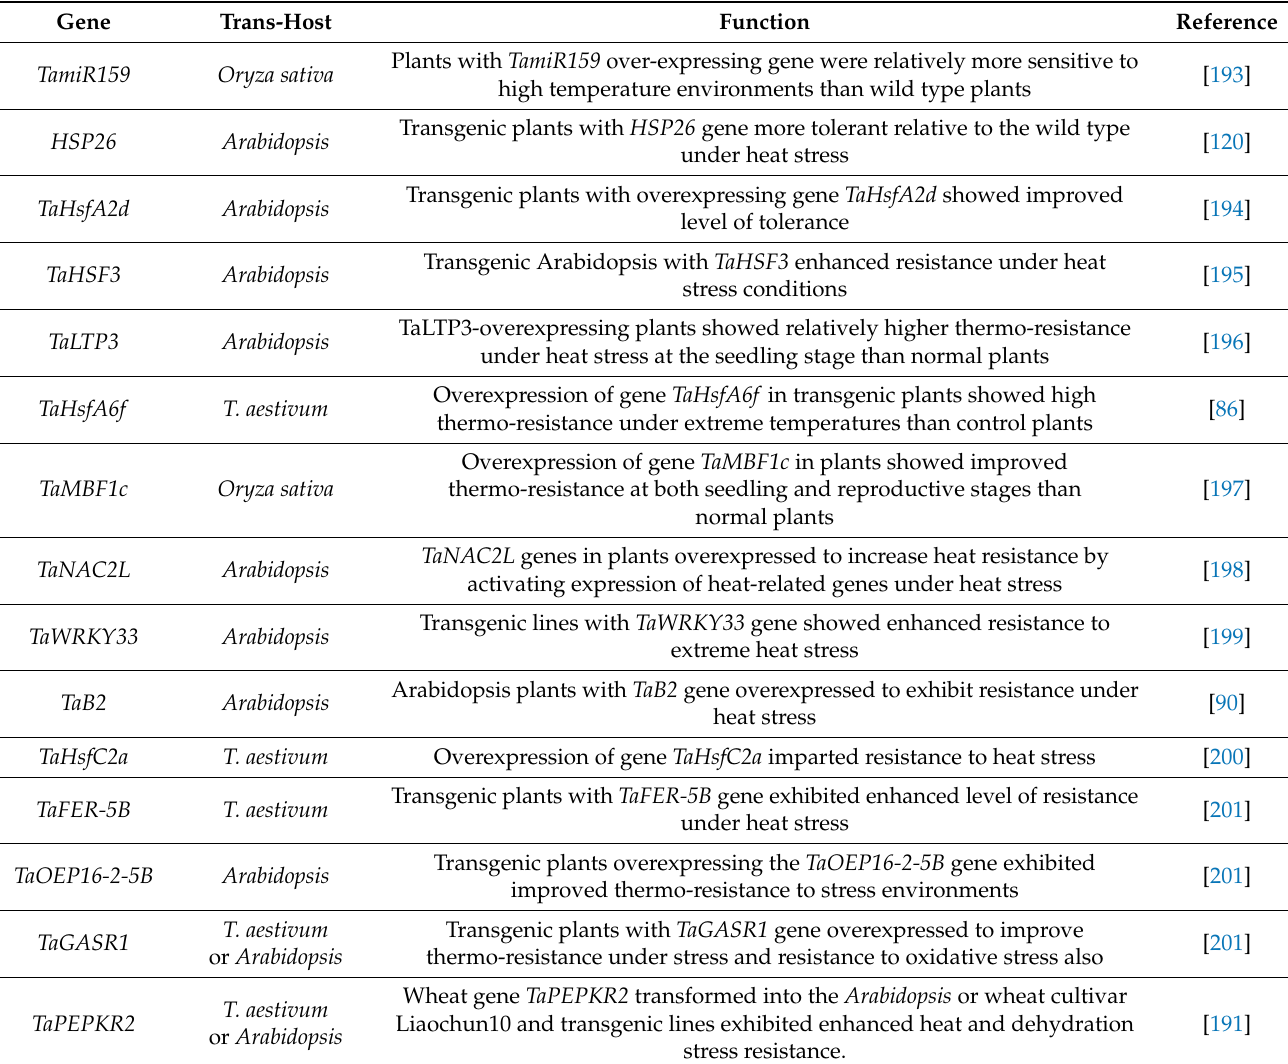
Table 5. Potential candidate genes of bread wheat for heat resistance in